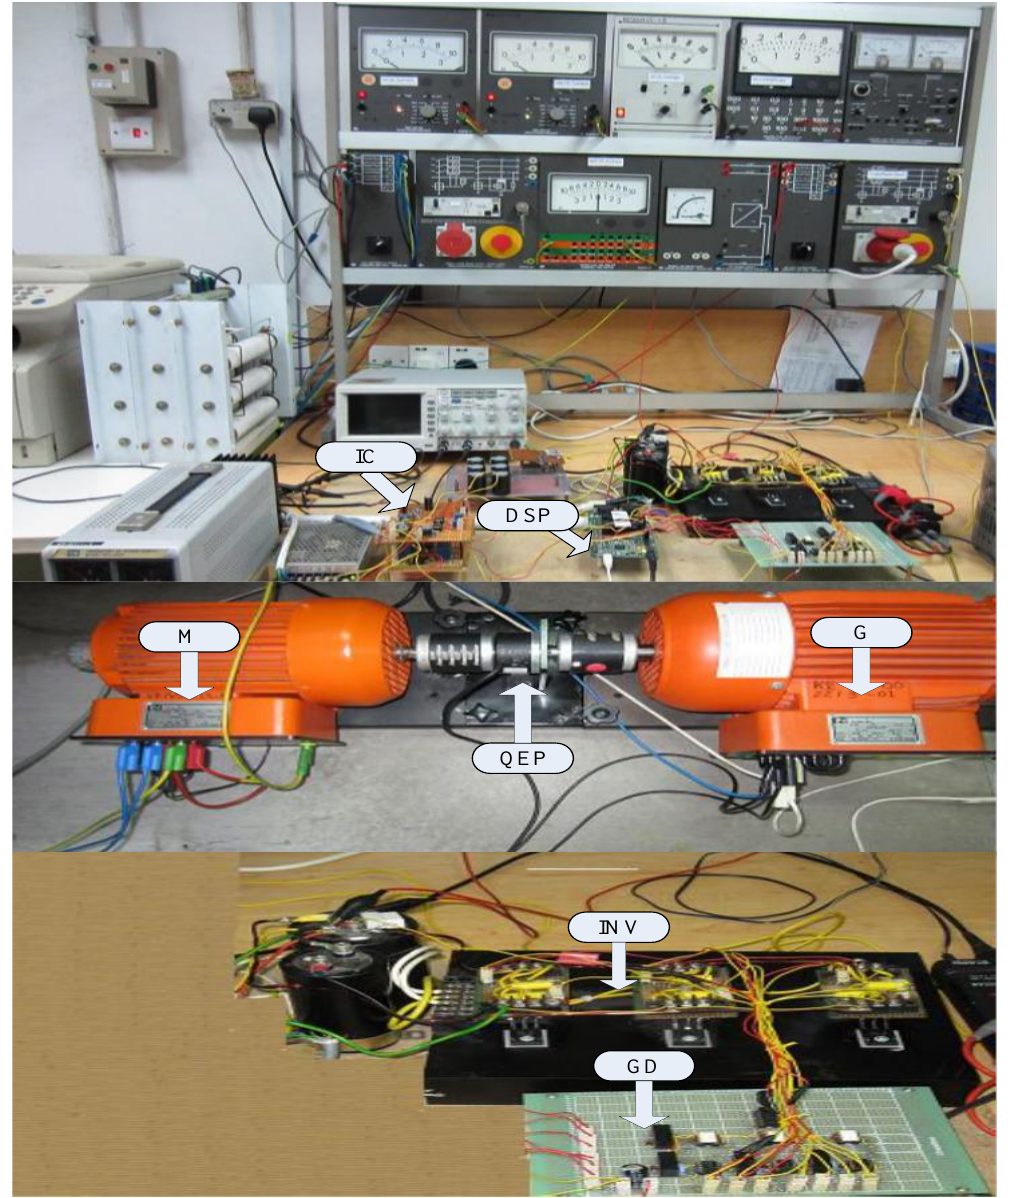
Figure 16. Experimental setup of the proposed IM